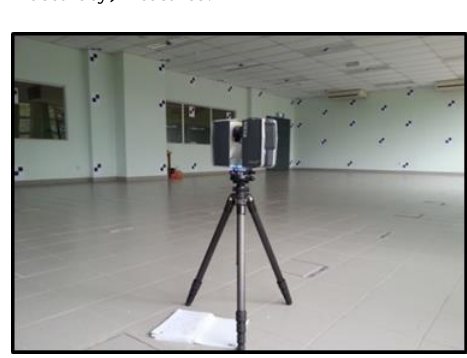
Figure 1. Self-calibration for the Faro Focus 3D scanner. was